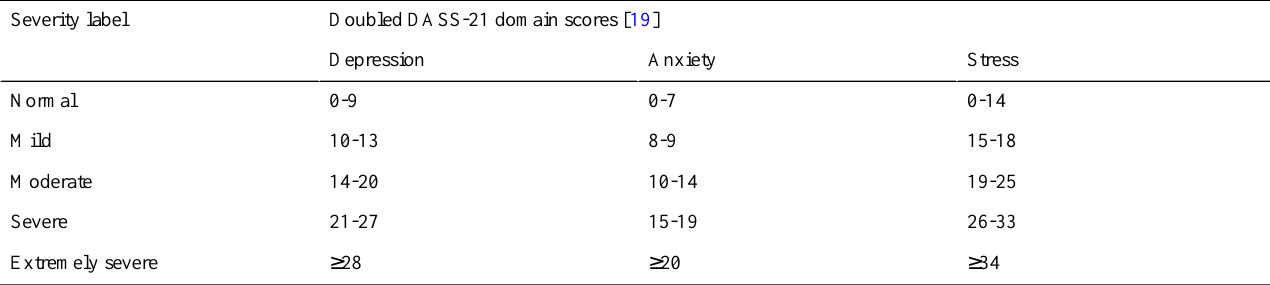
Table 1. Cutoff scores for depression, anxiety, and stress according to the Depression, Anxiety, and Stress Scale (DASS)-21. Doubled DASS-21 domain scores [19]Severity